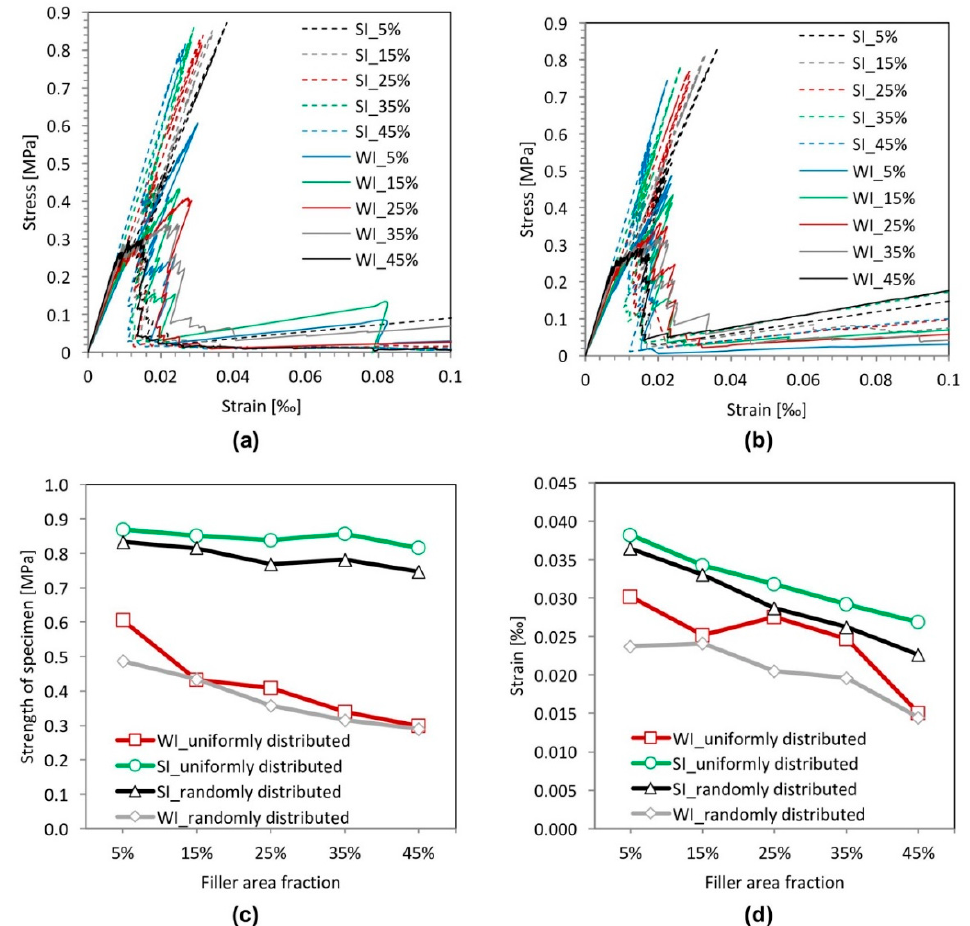
Figure 15. Simulated results of the filler area effect analyses for specimens with a strong interface (SI) and a weak interface (WI). ( a ) Stress-strain relation (uniformly distributed); ( b ) stress-strain relation (randomly distributed); ( c ) strength; ( d ) strain at peak stress.